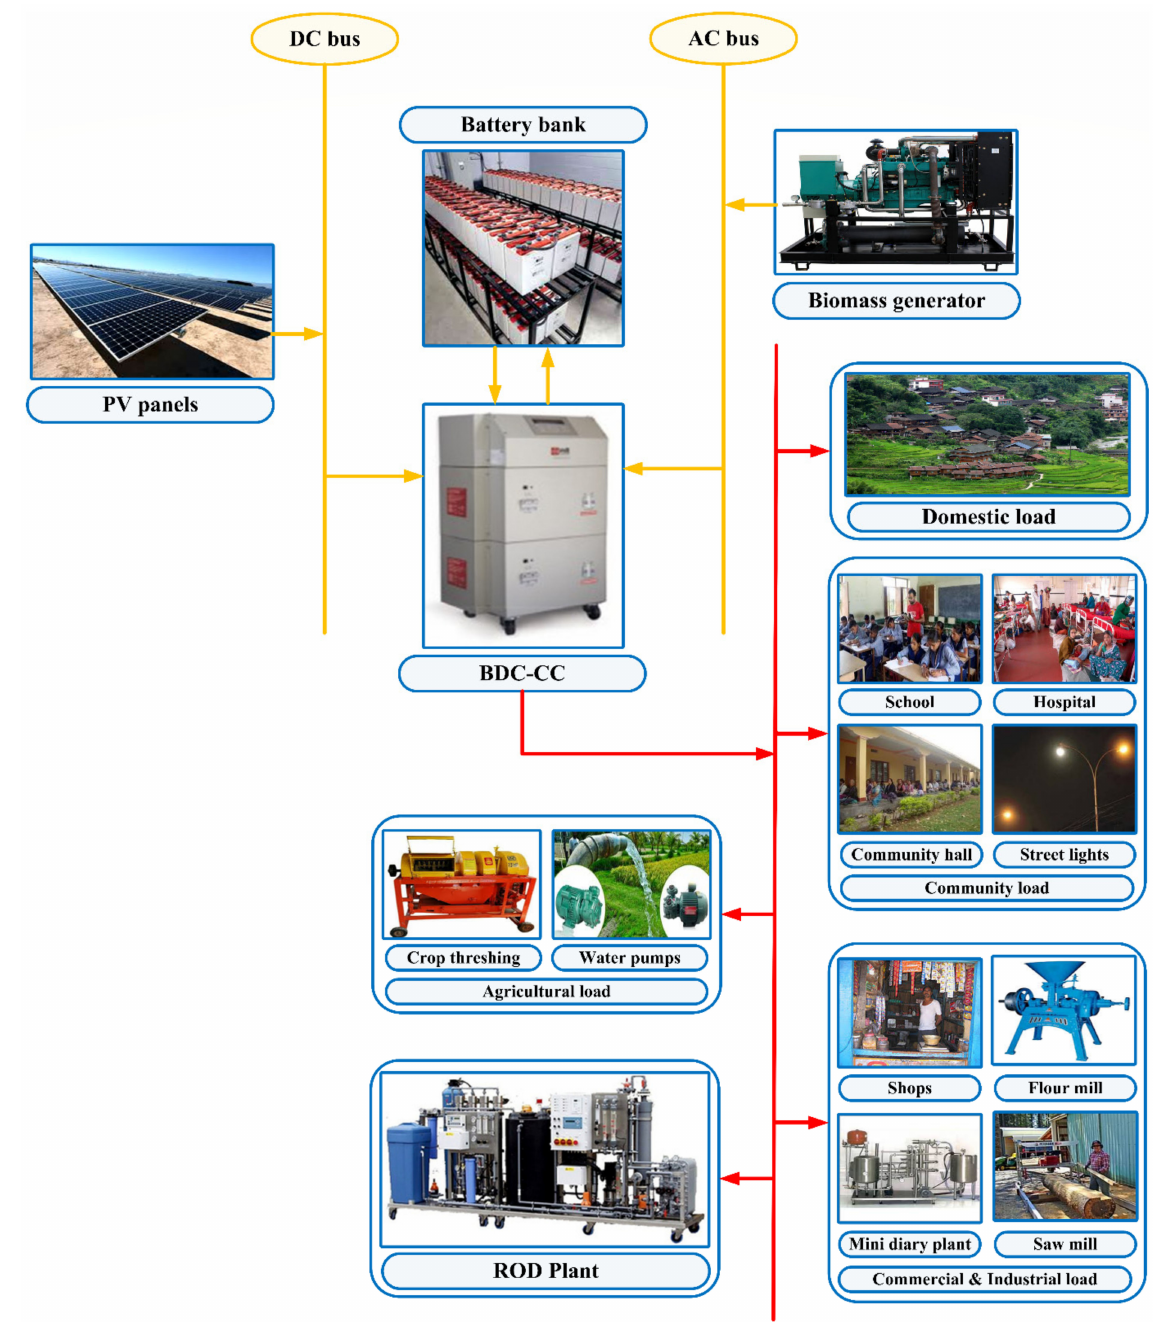
Figure 7. The schematic diagram of the